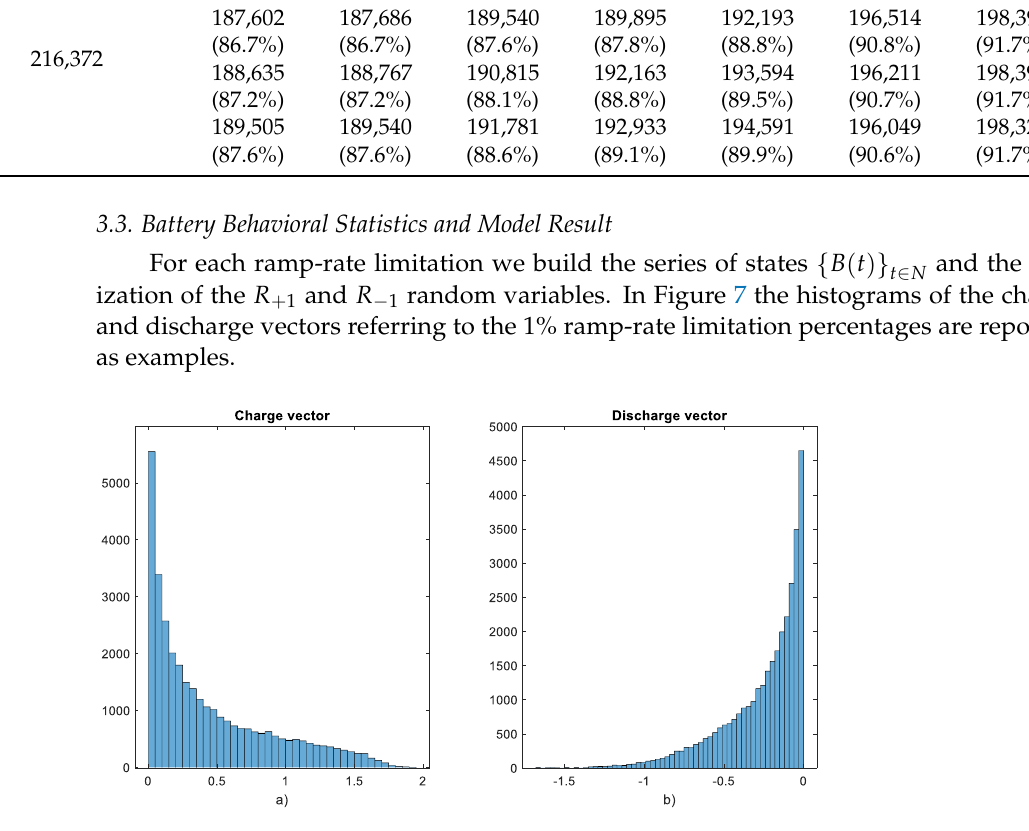
Figure 8. Graphical comparations between Weibull ( a ) and ( b ) and Exponential ( c ) and ( d ) cdf and ecdf for the 1% limitation charge and discharge vectors. Figure 9. Q-Q plot of charge and discharge vectors comparing the ecdf with the Weibull ( a , b ) and Exponential ( c , d ) distributions. In Tables 9–12 we report the main statistics referring to the distribution taken under consideration. The analyzed distributions fit well the empirical ones when the ramp-rate